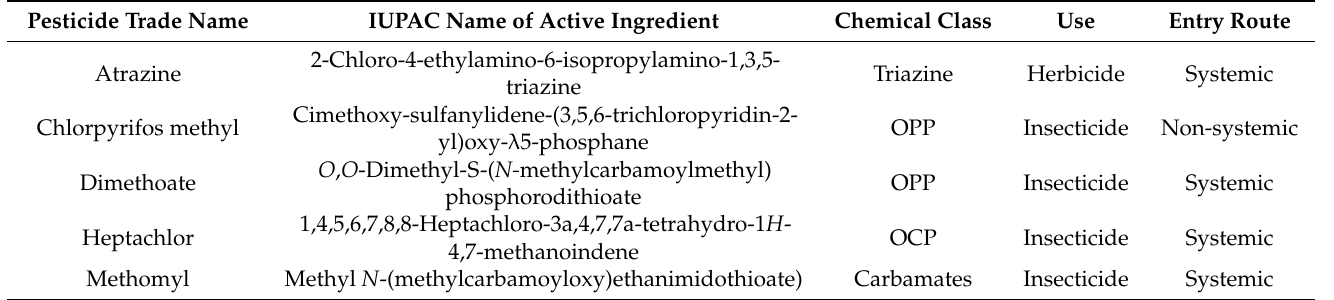
Table 1. Summary of the properties of the photodegraded pesticides